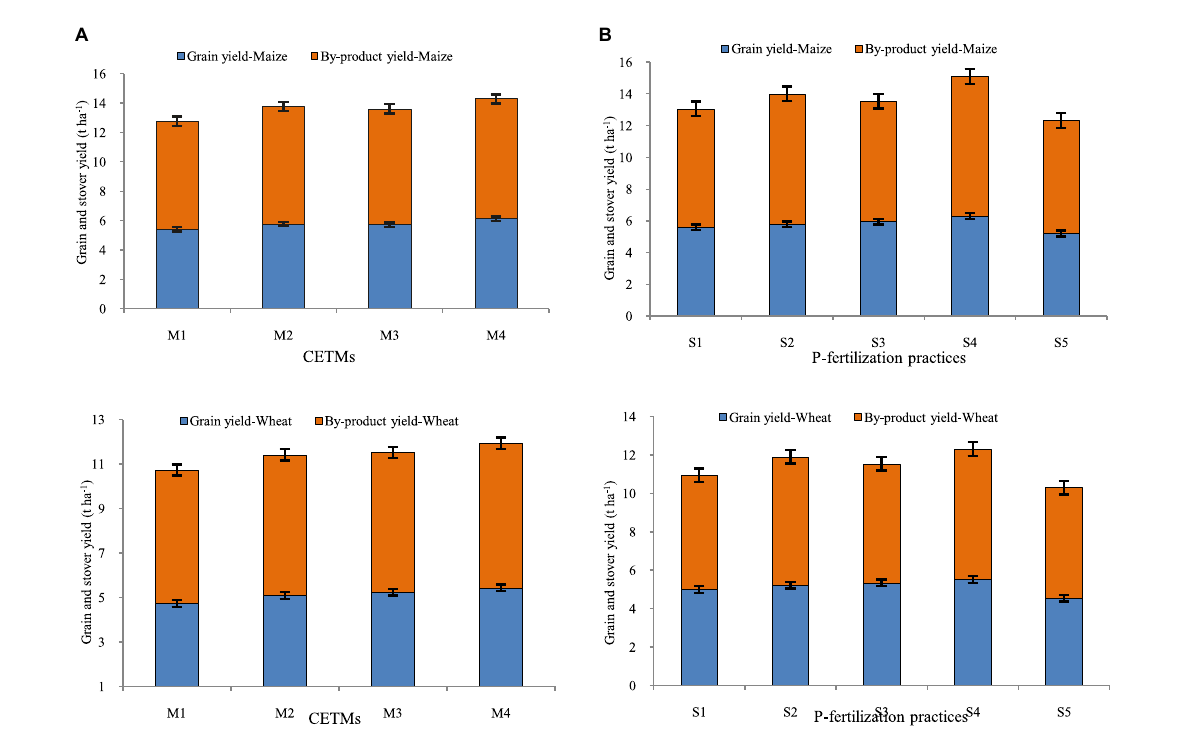
FIGURE5 Effect of crop establishment and tillage management (CETM) and P-fertilization practices on productivity of maize (A) and wheat (B) crop under MWCS (2-years’ av.). The vertical bars represent LSD 0 . 05 values. M 1 , flat bed–conventional tillage (FBCT) both in maize and wheat; M 2 , raised bed–CT (RBCT) in maize and RB–zero tillage (RBZT) in wheat; M 3 , FBZT both in maize and wheat; M 4 , permanent raised bed–ZT (PRBZT) both in maize and wheat. S 1 -P 100 , 100% P as basal; S 2 -P 50 + 2FSP, 50% P as basal (P 50 ) + 2 foliar sprays of phosphorus (2FSP) as DAP (2%) at knee-high stage (KHS) and pre-tasseling stage (PTS) in maize and at tillering stage (TS) and pre-flowering stage (PFS) in wheat; S 3 -P 50 + PSB + AMF, P 50 + PSB + AM-fungi (AMF); S 4 -P 50 + PSB + AMF + 2 FSP, P 50 + PSB + AMF + 2FSP at KHS and PTS in maize and at TS and PFS in wheat; S 5 -P 0 , 100% N and K with no P (P 0 ) as